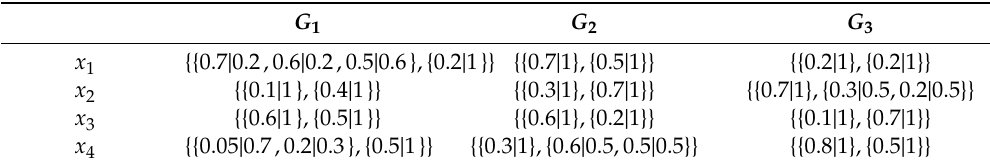
Table 2. The decision matrix A given by the domain